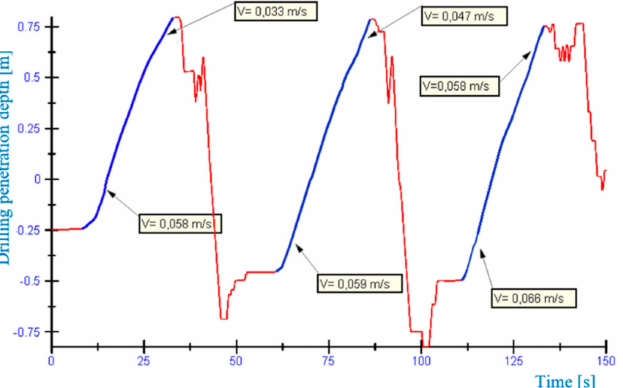
Figure 13. The course of the drilling process on the third test stand in the borehole No.